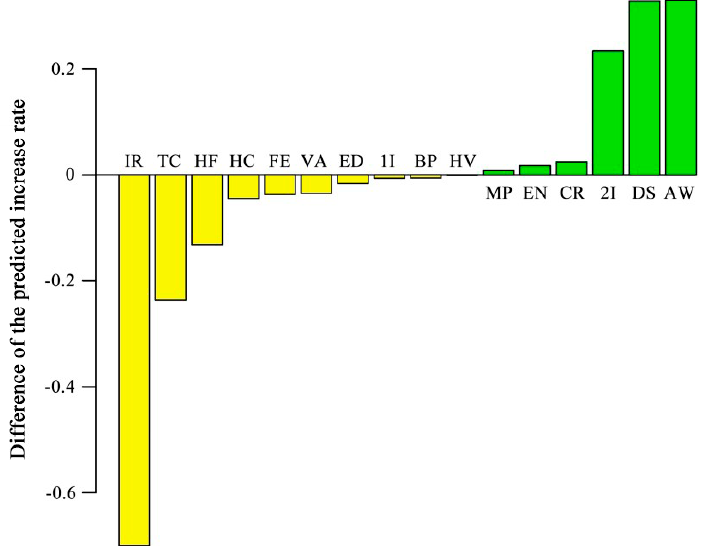
Figure 7. Influence of physicochemical properties on the anti-sintering of the Ni–Cs/Al 2 O 3 catalyst.